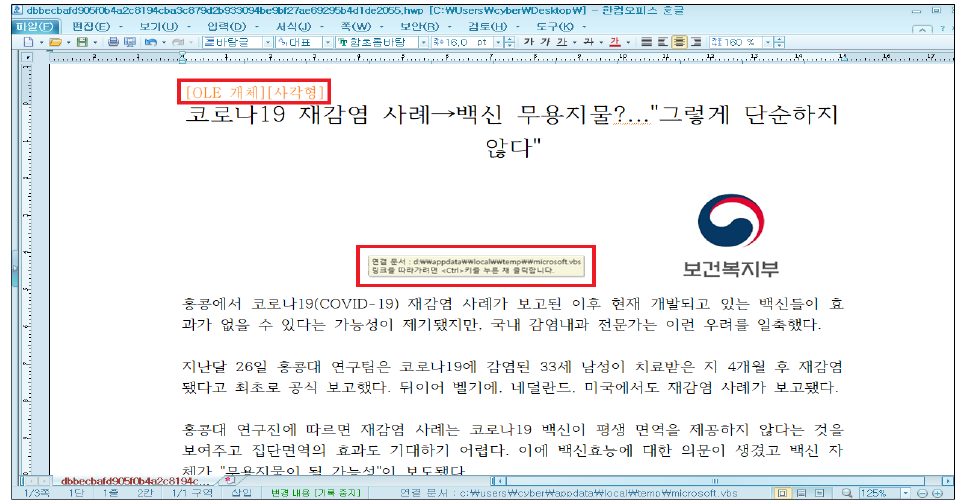
Figure 2. Execution screen of malicious HWP file using a news article.